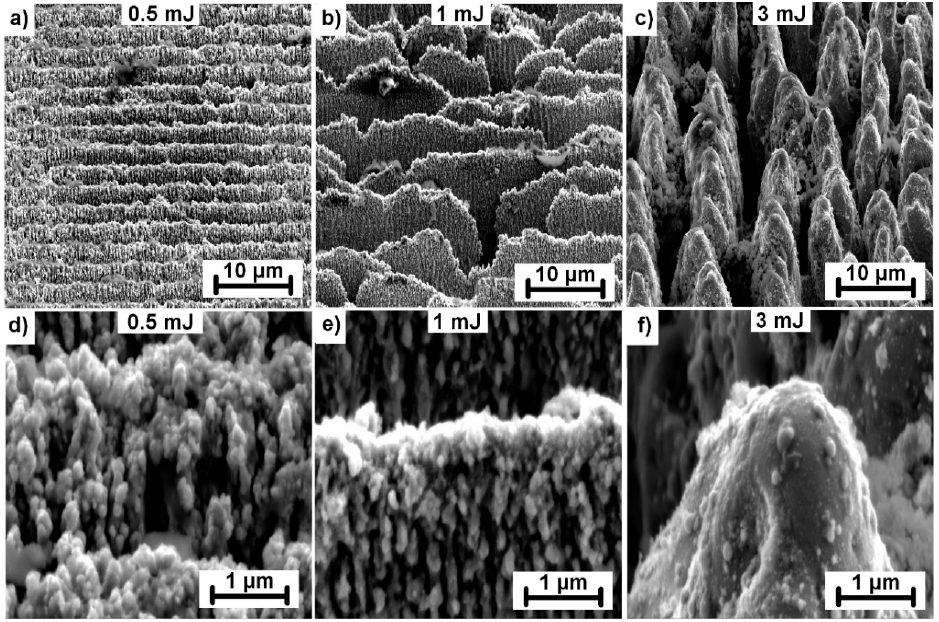
Figure 4. Structure evolution on a stainless-steel surface with increased pulse energy and 1000 consecutive laser pulses. Detail images with higher magnification are shown in the second row with the corresponding pulse energy. All images were captured with the sample tilted 55°.